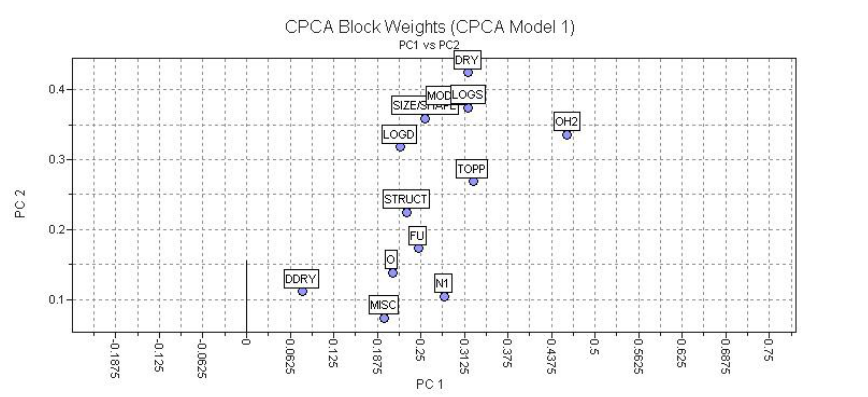
Figure 3. Plot of block weights considering PC or factor 1 and